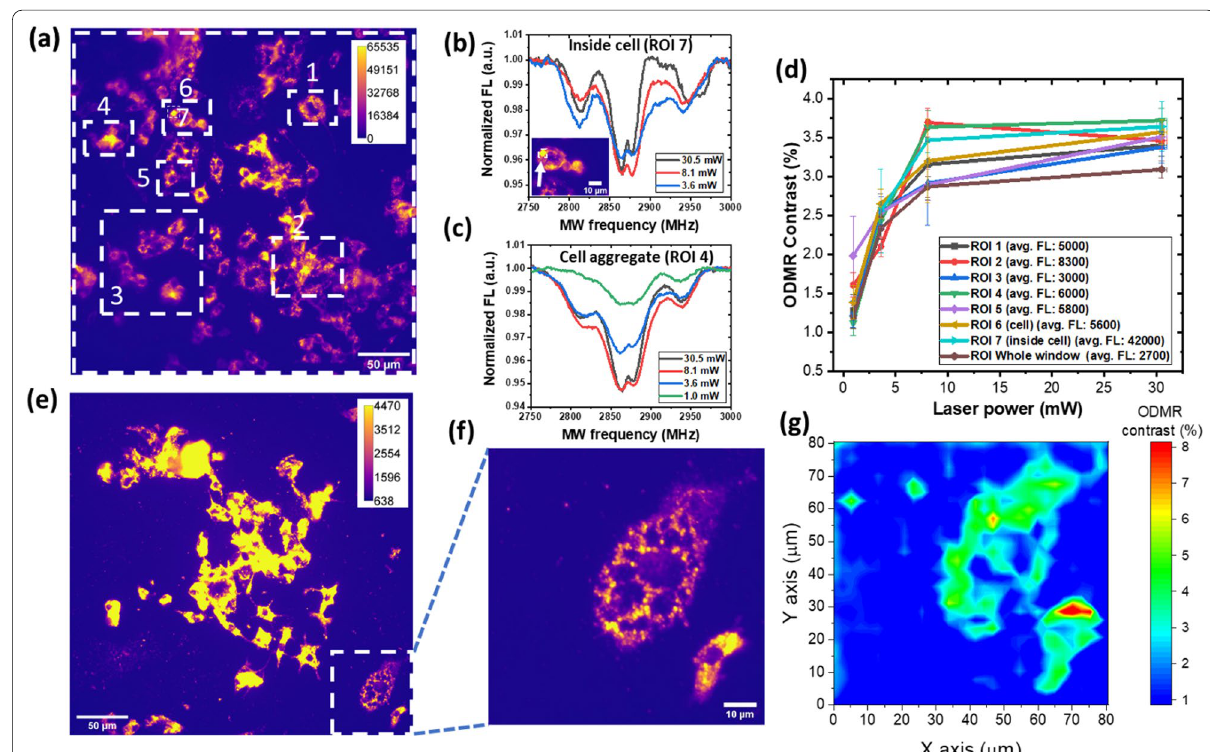
Fig. 5 ODMR contrast of NDs internalized in cells. a Fluorescence image of 156 nm NDs internalized in macrophage cells; the white square delineates the ROIs from which signals were extracted. NDs internalized within cells show inhomogeneous aggregation and concentration, resulting in a region‑dependent FL values. ODMR spectra presenting the NV − central lines ( A L and A R ) and the 13 C sidebands ( B L and B R ) at different laser power with constant MW power are shown in b for a single cell, and in c for a cellular aggregate. d ODMR curves corresponding to the ROIs of panel ( a ). The caption reports the average value of fluorescence intensity in each ROI. ODMR contrast steadily increases to 8.1 mW, while at higher laser powers it shows a plurality of behaviors. Small differences in the curves are uncorrelated with the average FL intensity and are supposedly related to local environment. e A color‑saturated fluorescence image of 156 nm NDs internalized in cells. The selected ROI f shows a cell with its different compartments and its nucleus. g Map of the distribution of ODMR contrast within the cells of ( f ). Contrast varies regionally, with an average value of